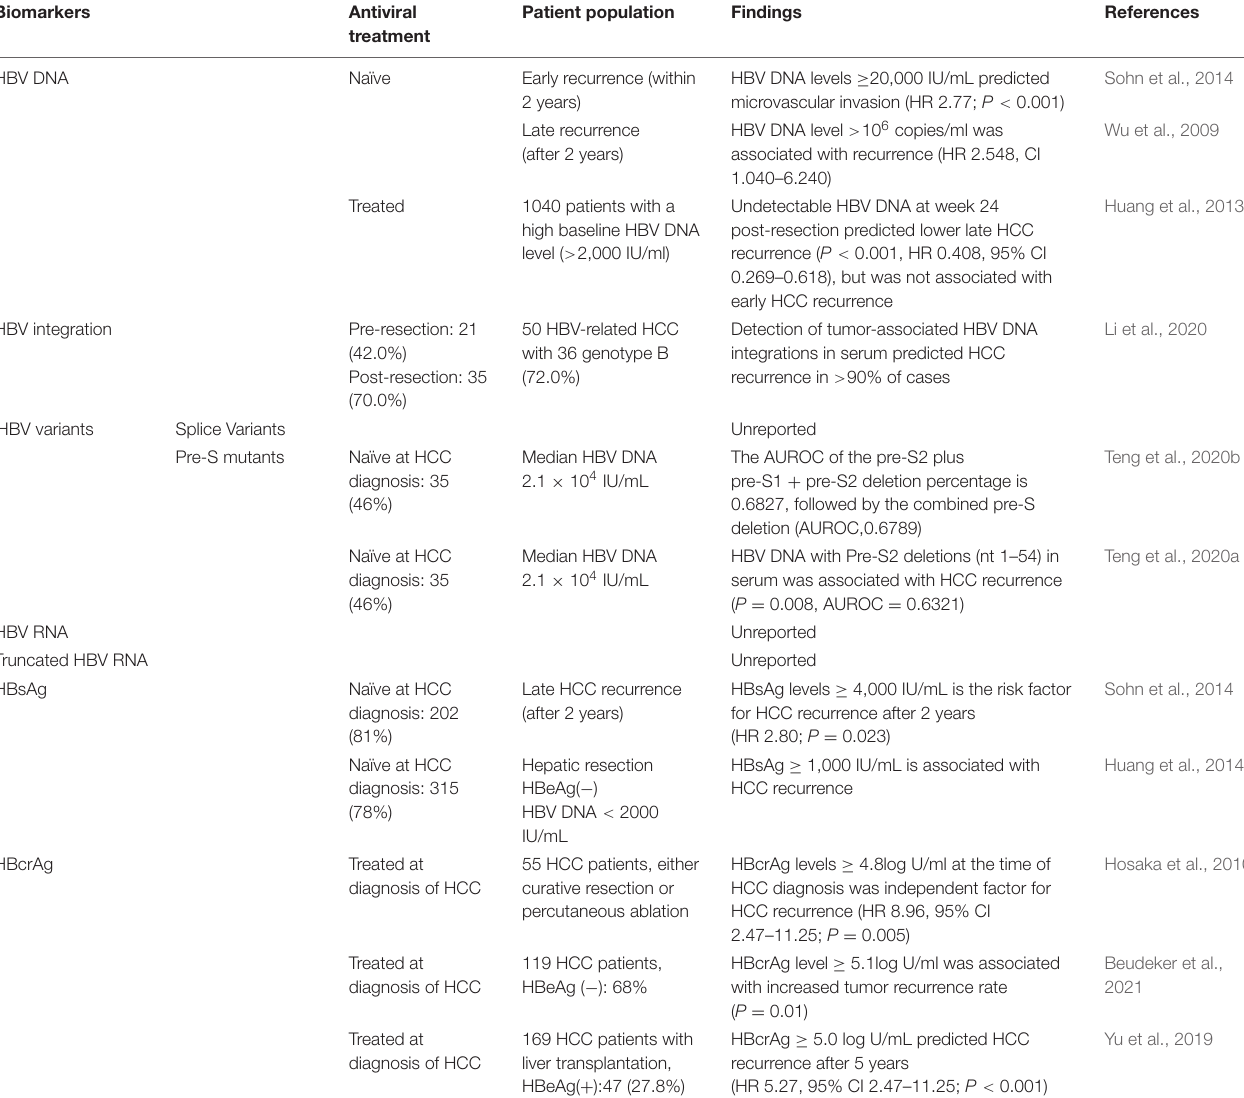
TABLE 3 | Serum viral biomarkers for the prediction of HCC